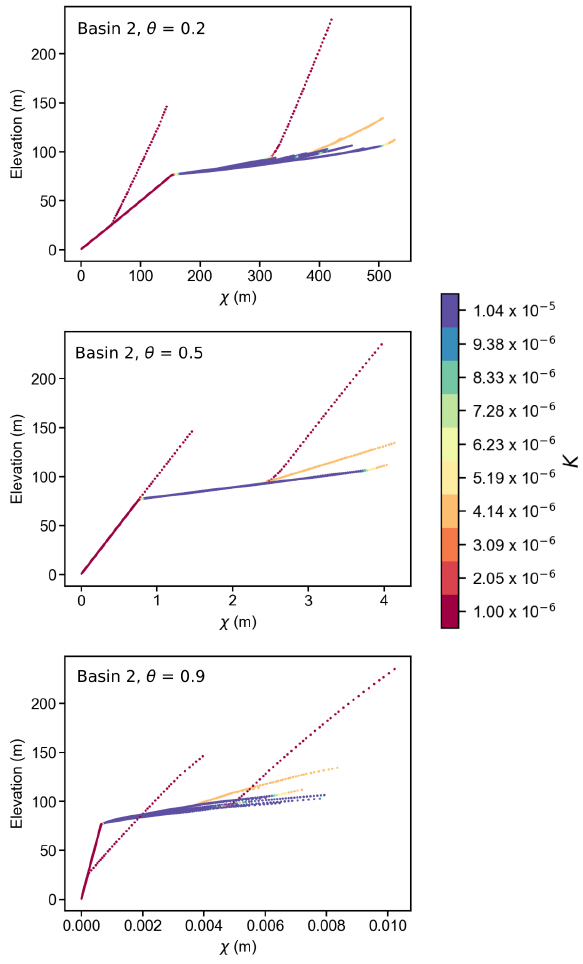
Figure 8. Example χ –elevation plots for the model run with spa- tially varying erodibility, where points are coloured by K . The m/n increases in each plot from 0.2 to 0.9. Tributaries with the same K value are collinear in χ –elevation